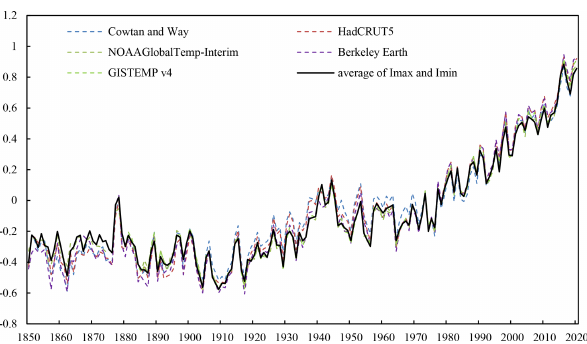
Figure 10. Comparison of GMST anomaly series (relative to 1961– 1990 average) for different datasets. The GMST anomaly series cal- culated based on the weighted average of global mean LSAT and SST series according to the sea–land ratio. The average of Imax and Imin is the average of GMST series of CMST 2.0 − Imax and CMST 2.0 −